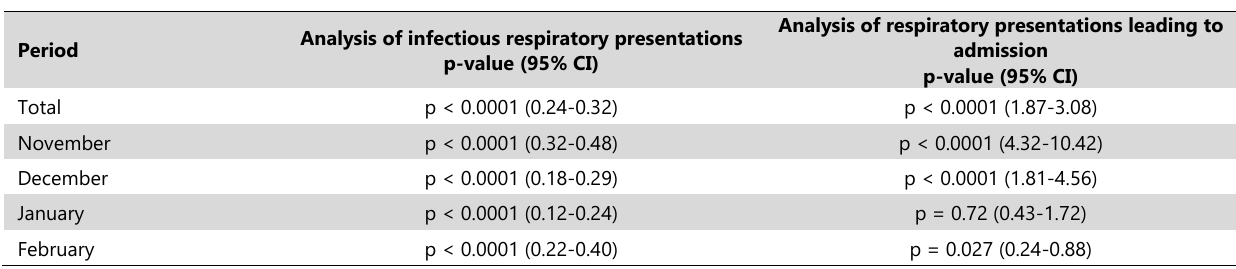
Table 3. Statistical Analysis Comparing Winter Pre-COVID-19 (November 2019 – February 2020) and During-COVID-19.